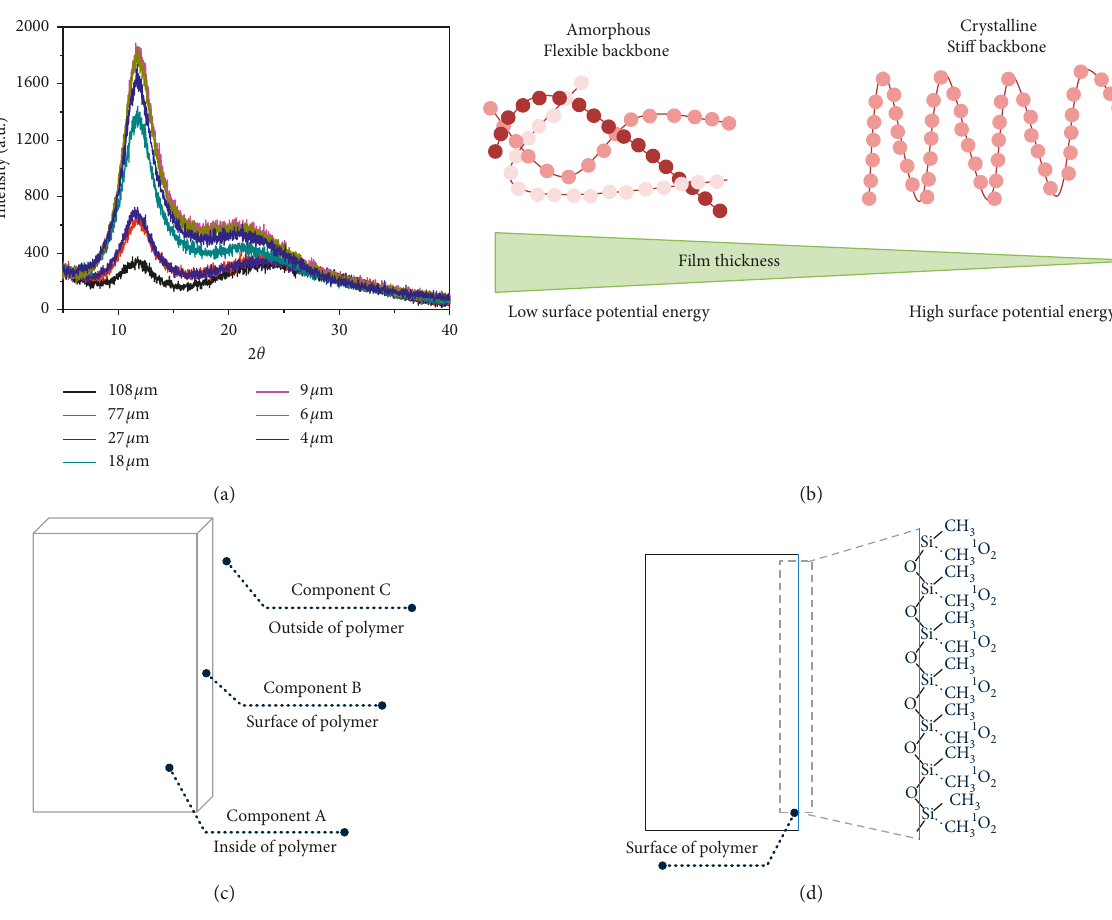
Figure 2: (a) The EDX spectra of PFPFs, (b) Schematic of polymer matrix structures (c) Schematics of singlet oxygen deactivation space, and (d) Cross section of the polymer